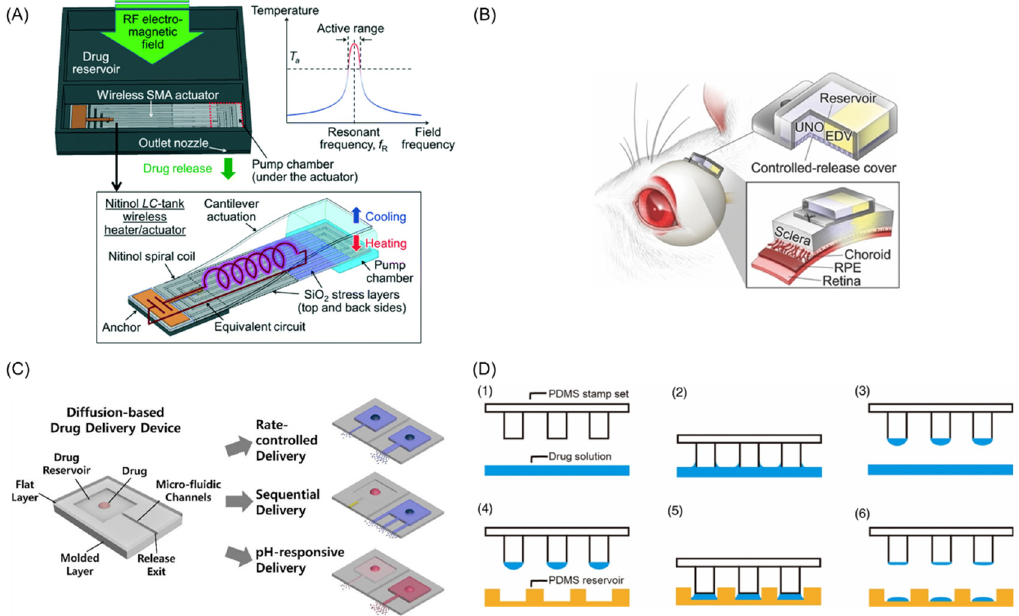
Figure 3. ( A ) Schematic diagram of wireless implantable magnetic driven DDSs and its working principle. ( B ) Working diagram of dual-drug delivery system. ( C ) The “reservoir-microfluidic channel” system optimization and drug release diagram. ( D ) Schematic diagram of the wet μ CP system manufacturing: (1) PDMS stamp set and drug solution, (2) tip contact with drug solution,(3)drug coated stamps,(4)The position of drug coated stamp above PDMS reservoir,(5) stamp contact on a target surface and (6) final drug loading formation. ( A ) Jeffrey Fong et al. [80]; ( B ) Nobuhiro et al. [82]; ( C ) Yang et al. [84]; ( D ) Lee et al. [85].